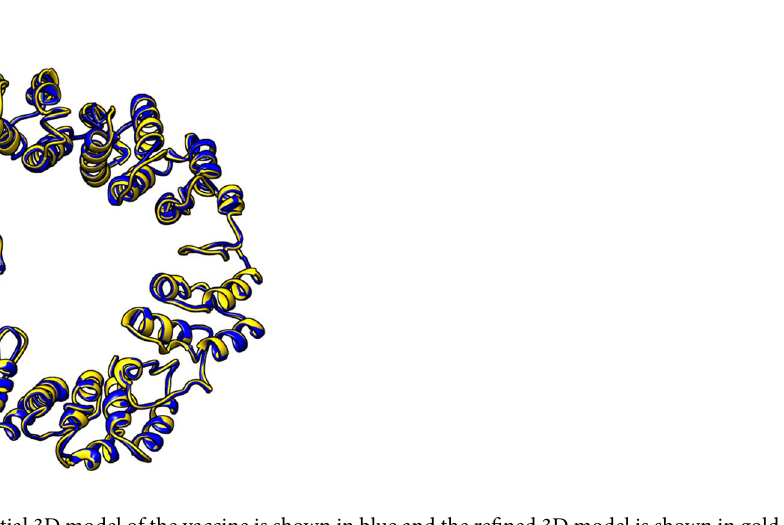
Figure 3. The initial 3D model of the vaccine is shown in blue and the refined 3D model is shown in gold. The UCSF Chimera 1.15rc software was used to visualize